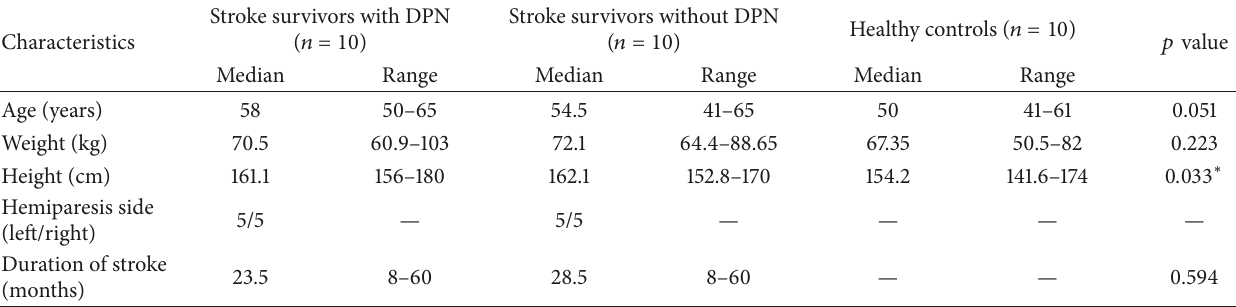
Table 1: Demographic information of